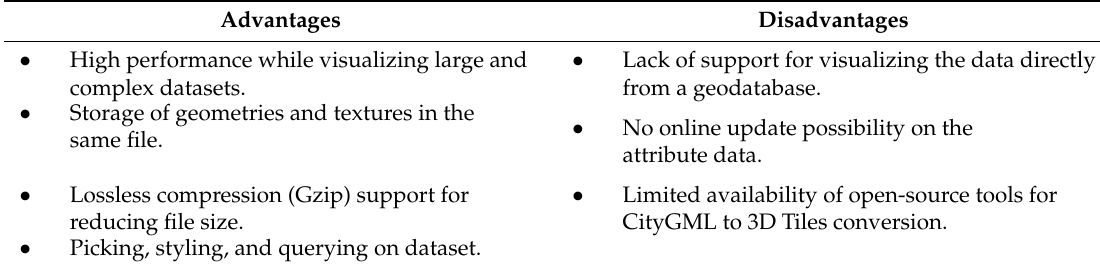
Table 1. Advantages and disadvantages of 3D Tiles as experienced in this study.